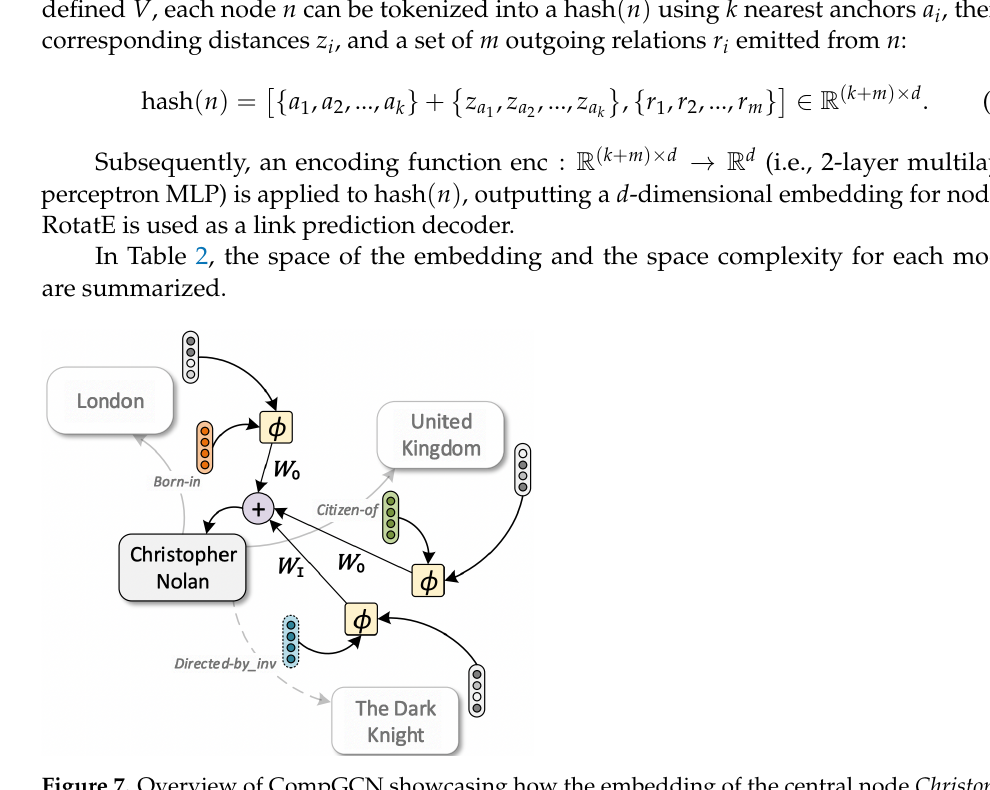
Figure 7. Overview of CompGCN showcasing how the embedding of the central node Christopher Nolan is updated. First, a composition operation φ ( · ) over each neighboring node and the corre- sponding edge is performed. The composed embeddings are then convolved with specific filters W O and W I for direct and inverse relations, respectively; self-loops are omitted for clarity. Finally, the messages from all neighbors are aggregated to obtain an updated embedding of the central node. Re-elaborated from [38]. Table 2. Embedding dimensions and space complexity for the models included in our analysis. N e and N r , respectively, denote the number of entities and relation types, i.e., N e = |E| and N r = |R| ; d is the embedding dimension; K is the number of layers; B represents the number of bases; T is the number of filters; and m and n are the dimensions of the